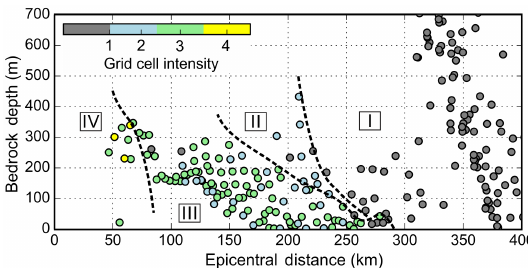
Figure 13. Bedrock depth of grid cell centroids (see Fig. 12) ver- sus epicentral distance to the Ramsgate M L 4.2 earthquake. Only data from the continent. Dashed lines limit maximal depth–distance relation for the indicated